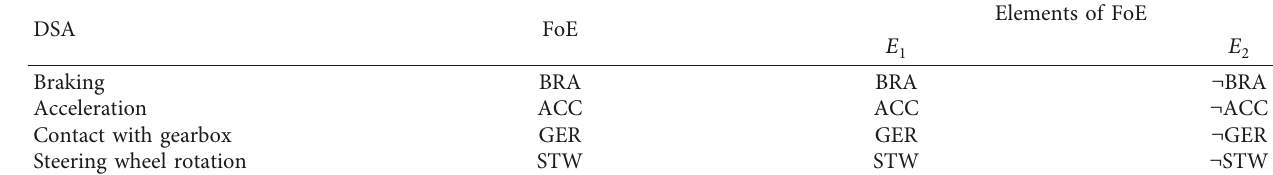
Table 2: FoE of inside SI.